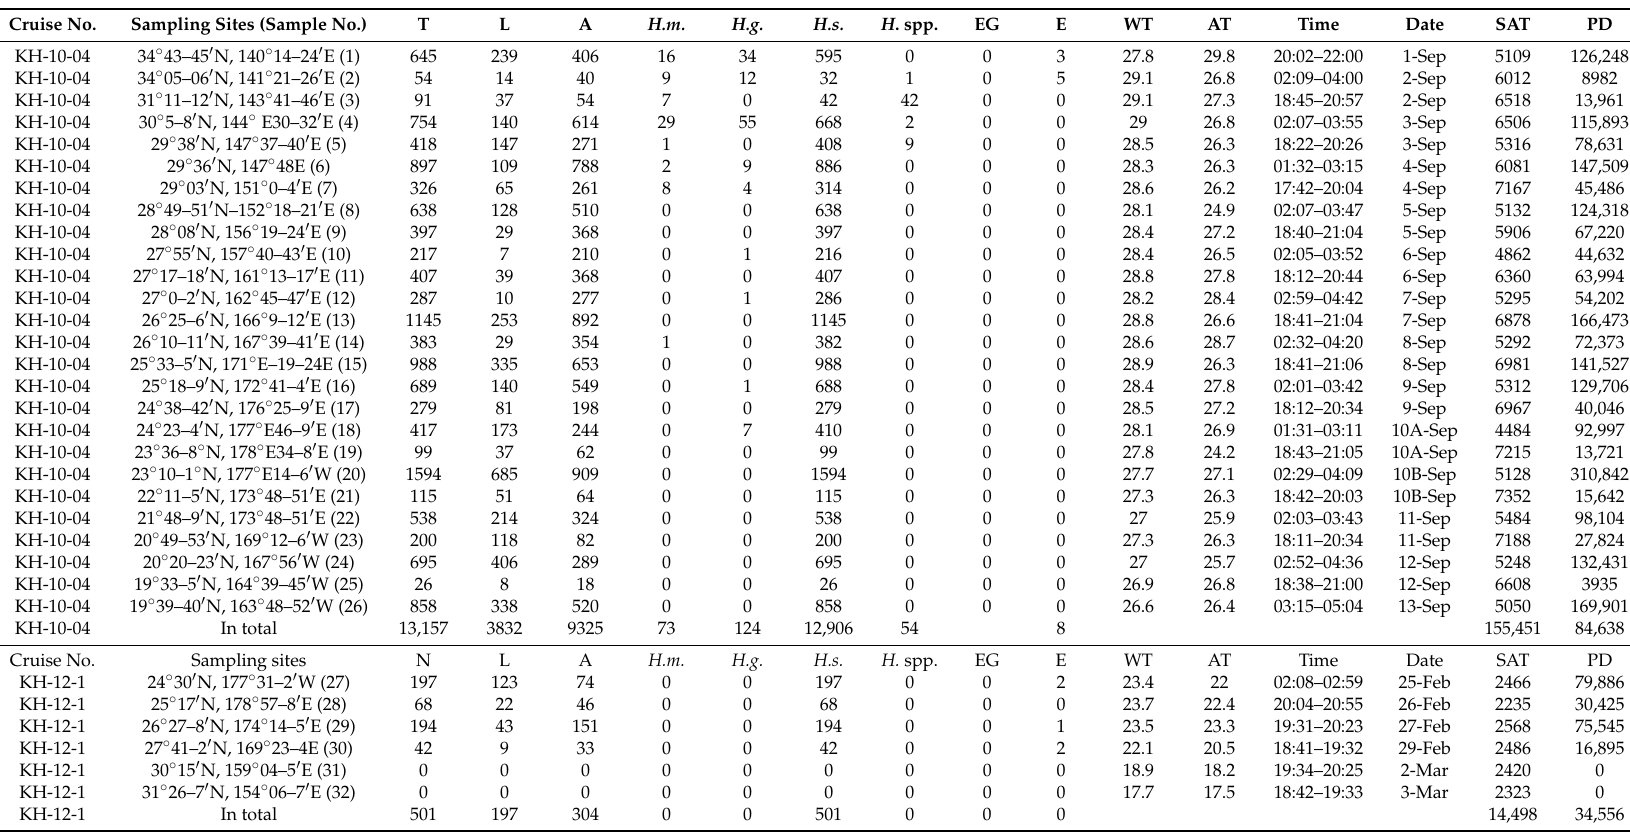
Table 1. The oceanic skaters, Halobates were collected at sites along the cruise tracks between Tokyo and Honolulu in September, 2010 (A-Cruise: KH-10-04-Leg 1), and in February and March 2012 (B-Cruise: KH-12-01-Leg 2). T: Total number of individuals collected; L: Larvae, A: Adults; H.g. : Halobates germanus ; H.m. : Halobates micans ; Date: Sampling date; SAT: Area of water surface over which the Neuston net was trailed by the ship, R/V HAKUHOMARU (One unit of sampling was performed for 15 min; six (or eight) units in A-Cruise and three units in B-cruise were performed at each sampling site); PD: Population Density (individuals/km 2 ). Cruise